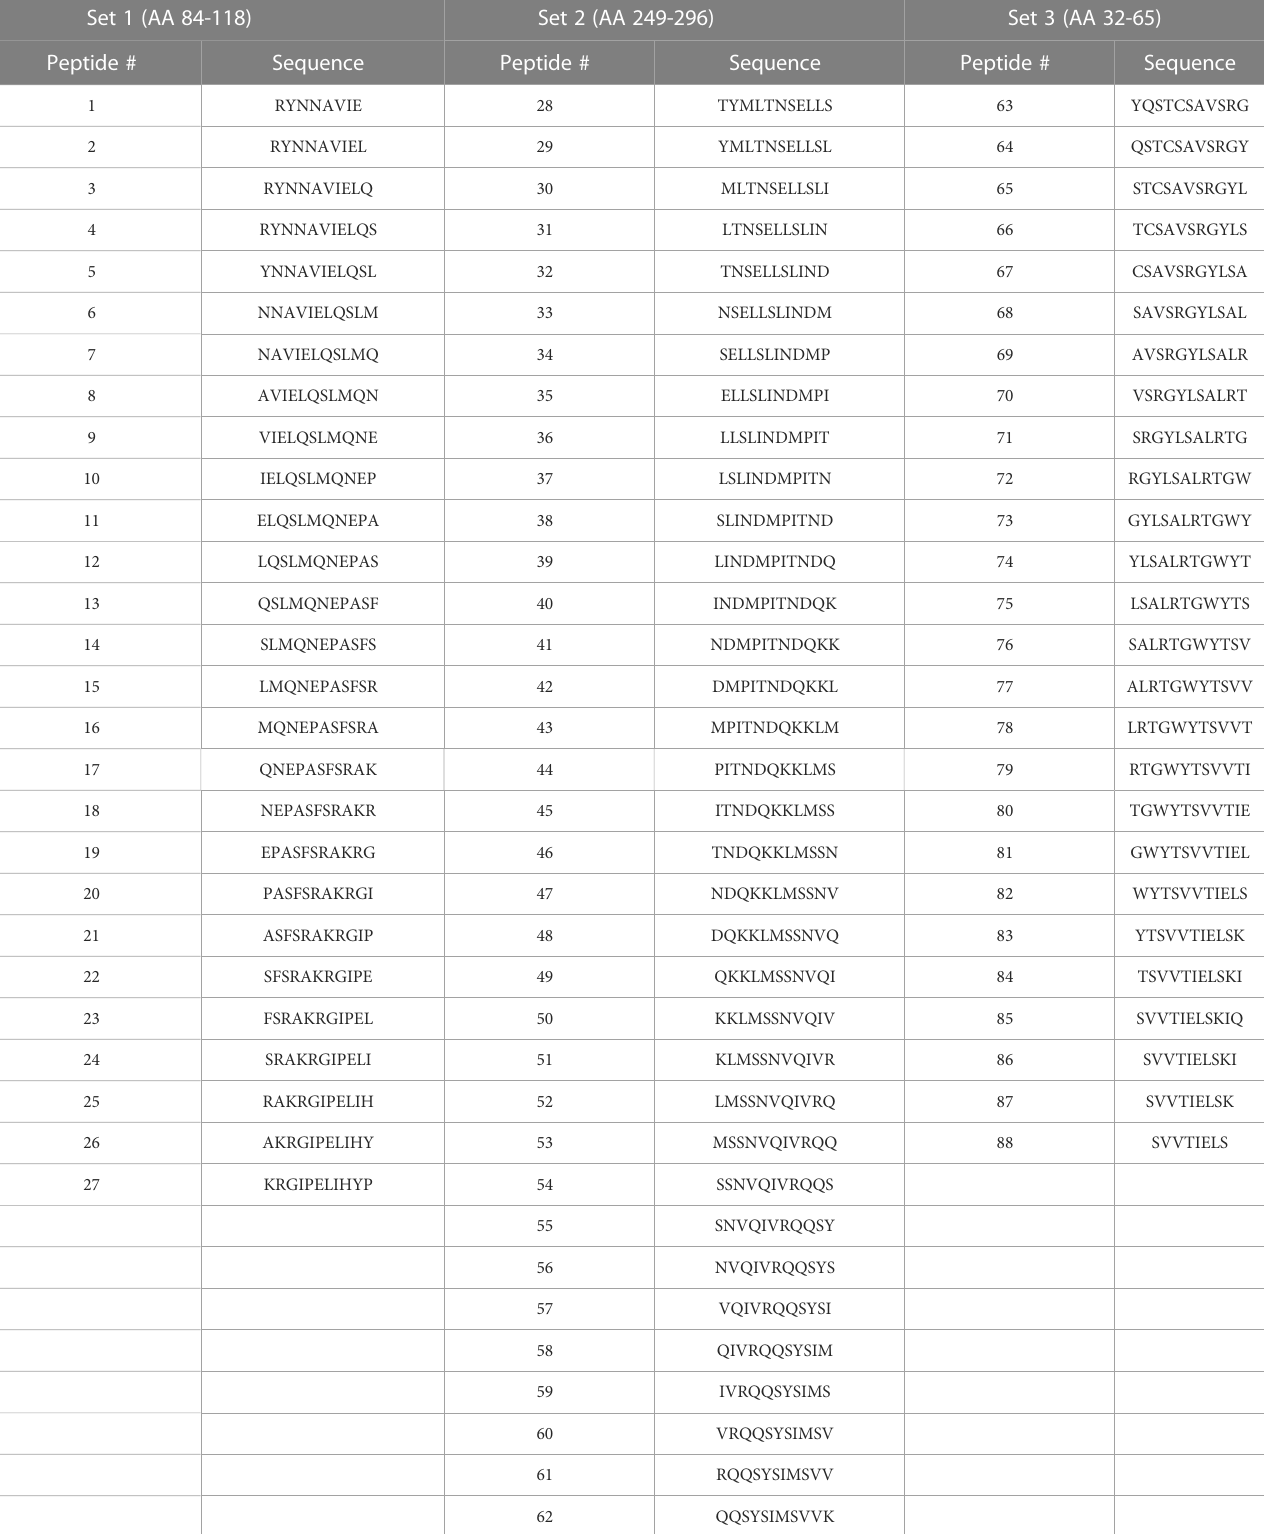
TABLE 1 BRSV F protein overlapping peptide library sequences. Set 1 (AA